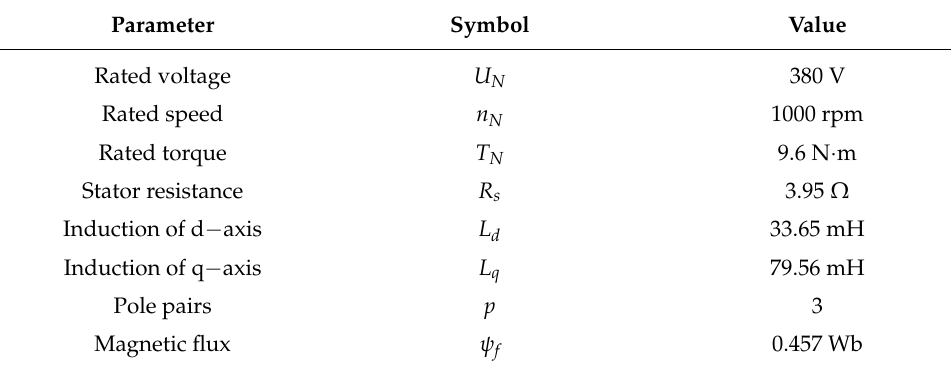
Table 1. Nominal values of PMSM parameters.